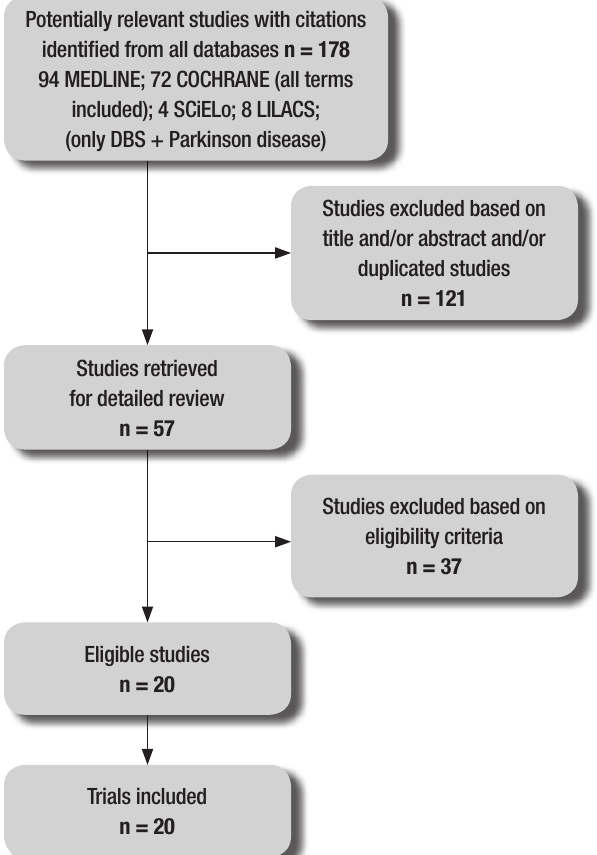
Trials included n = Figure 1. Flow diagram of studies included in the review.